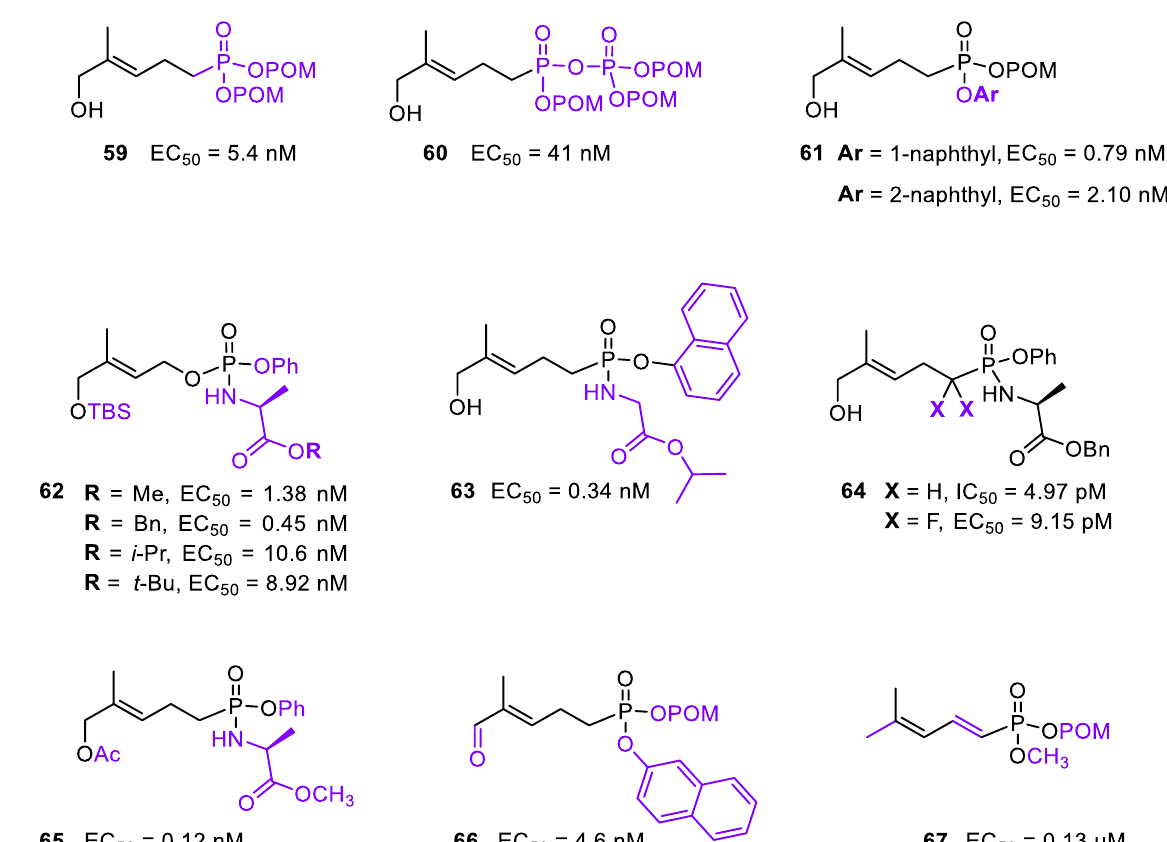
Figure 10. Prodrugs of